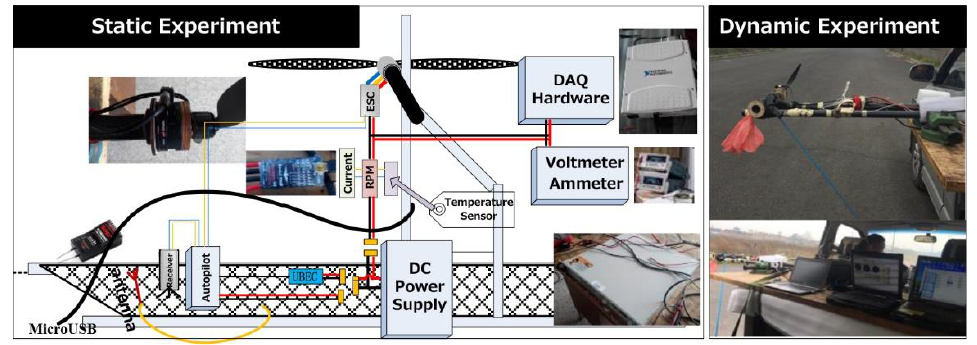
Figure 4. The setup of the propulsion system static and dynamic experiment.